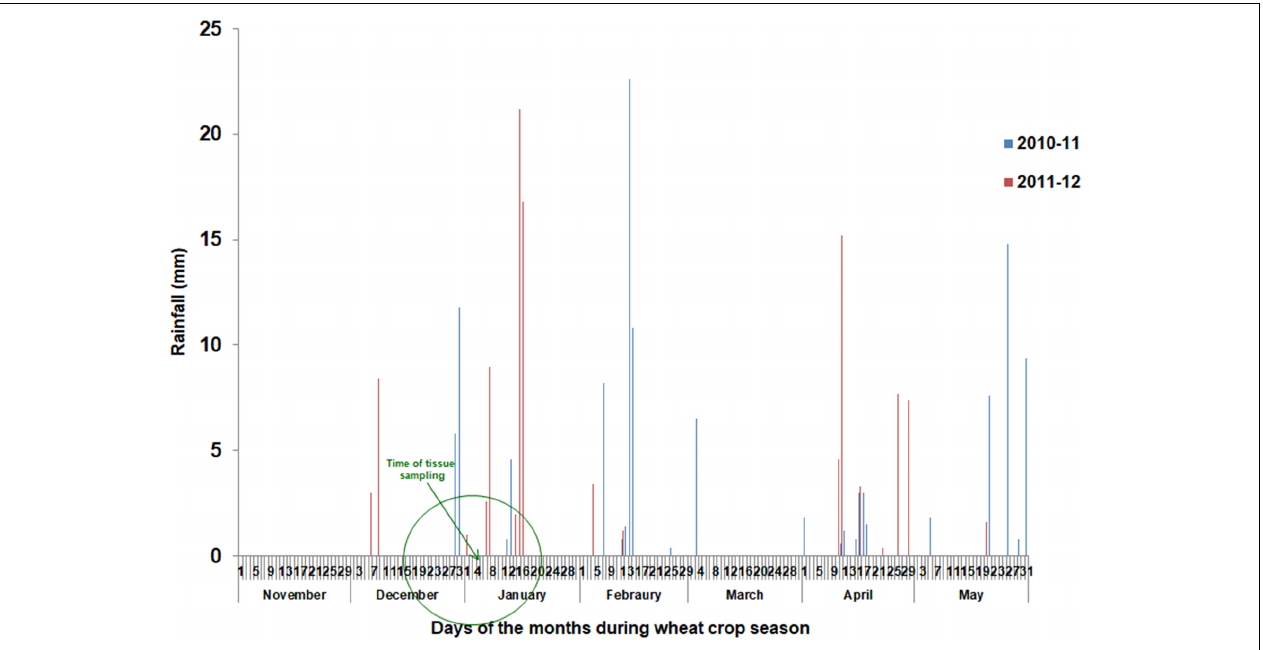
FIGURE 1 | Rainfall pattern during period of field